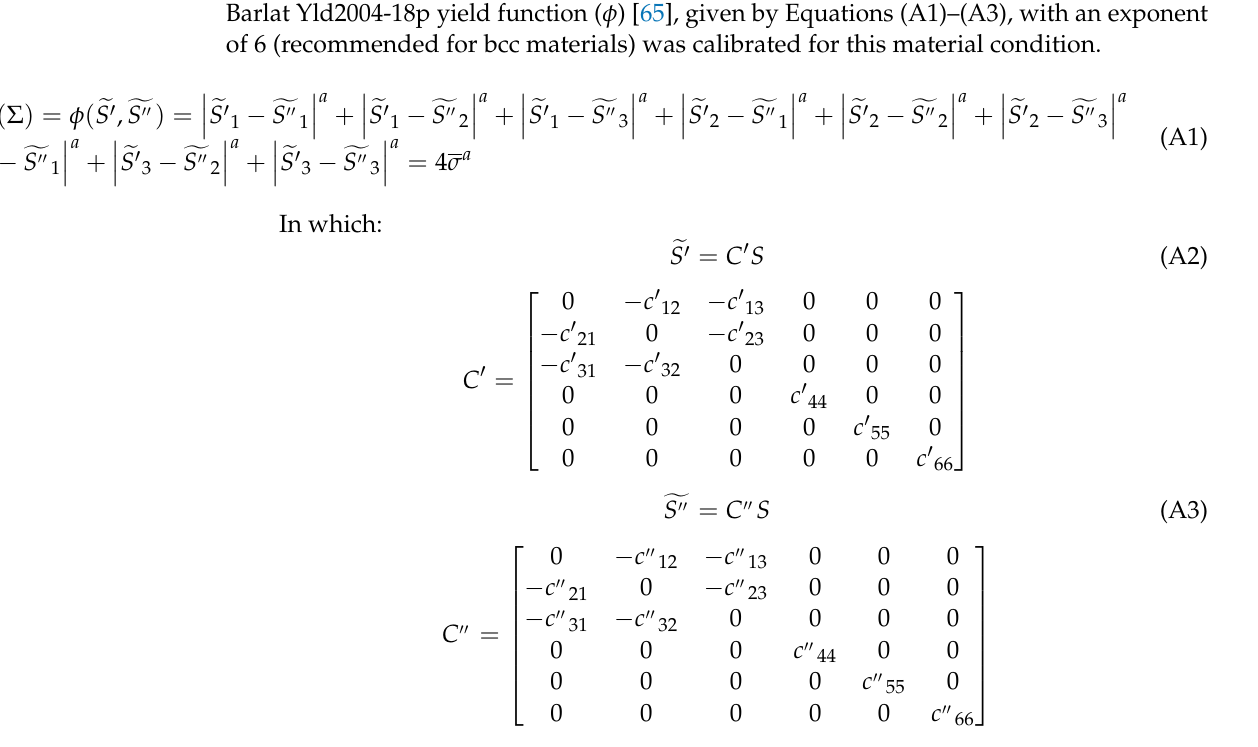
a : The stress ratios are averaged, normalized values relative to the tensile stress along the rolling direction (RD) corresponding to the plastic work (36.7 MJ/m 3 ) conducted along the diagonal (weakest) direction (DD) until the UTS point; b : the calculated Lankford’s coefficients are averaged within a range of 1% elongation to the UTS (uniform) elongation; and c: the variations denote the standard deviation of the measured